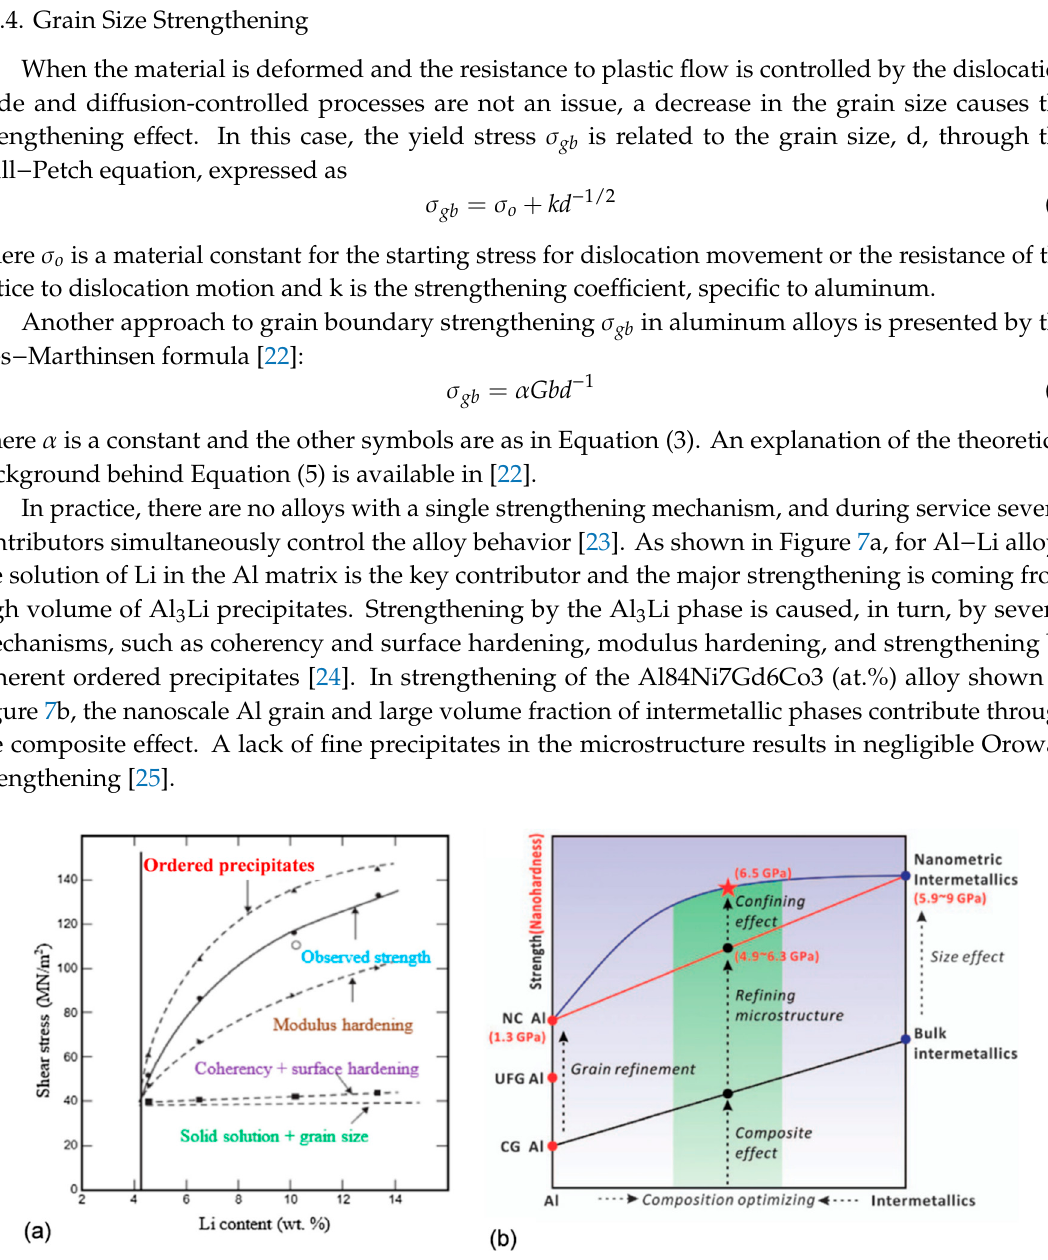
Figure 7. Contribution of different strengthening mechanisms in various aluminum alloys: ( a ) Al − Li alloys with Al 3 Li precipitates [26,27] and ( b ) Al84Ni7Gd6Co3 (at.%) alloy, produced by a combination of gasification, ball milling, and hot pressing [25].